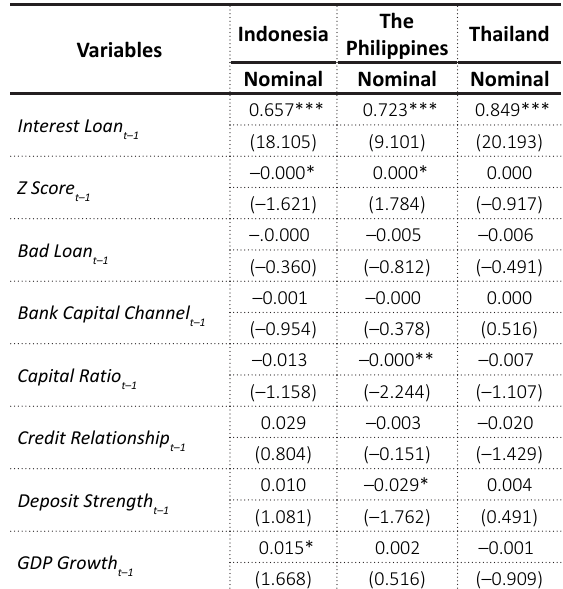
Table 3. Regression results of the Loan Interest Rate